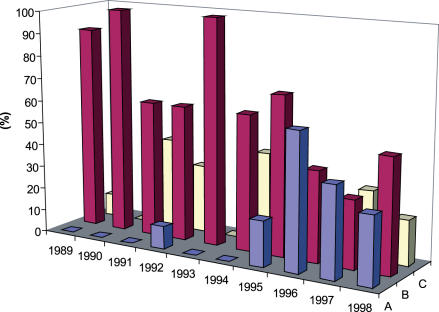
The Use of the Calvert Formula in Clinical Trials from 1989 to 1998A PubMed search for the dosing of carboplatin in clinical trials was performed for the period 1989–1998. For each year the first ten results of PubMed were screened for the use of the Calvert formula. Bars represent the percentage of results in which the Calvert formula was used to dose carboplatin (A), the Calvert formula was not used (B), or no dosing information could be retrieved electronically (C).